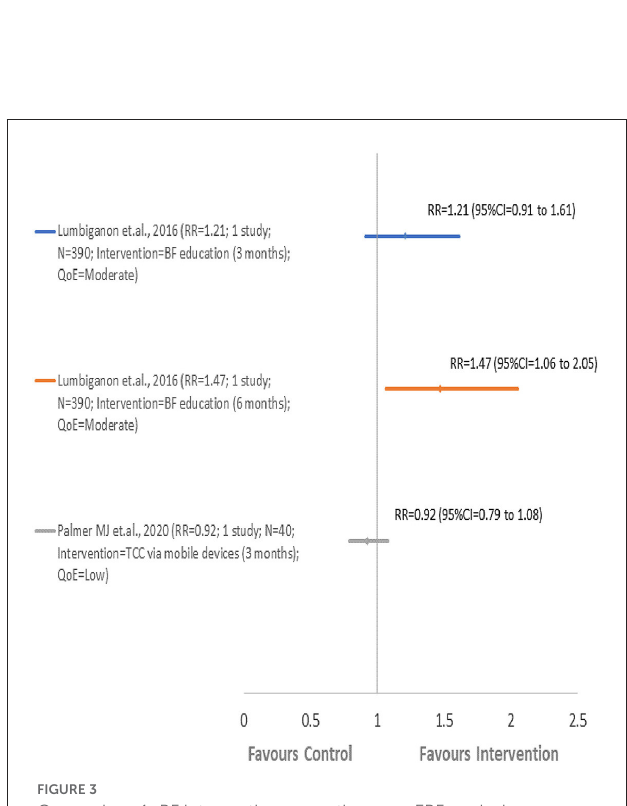
FIGURE3 Comparison 1: BF intervention vs. routine care. EBF, exclusive breastfeeding.